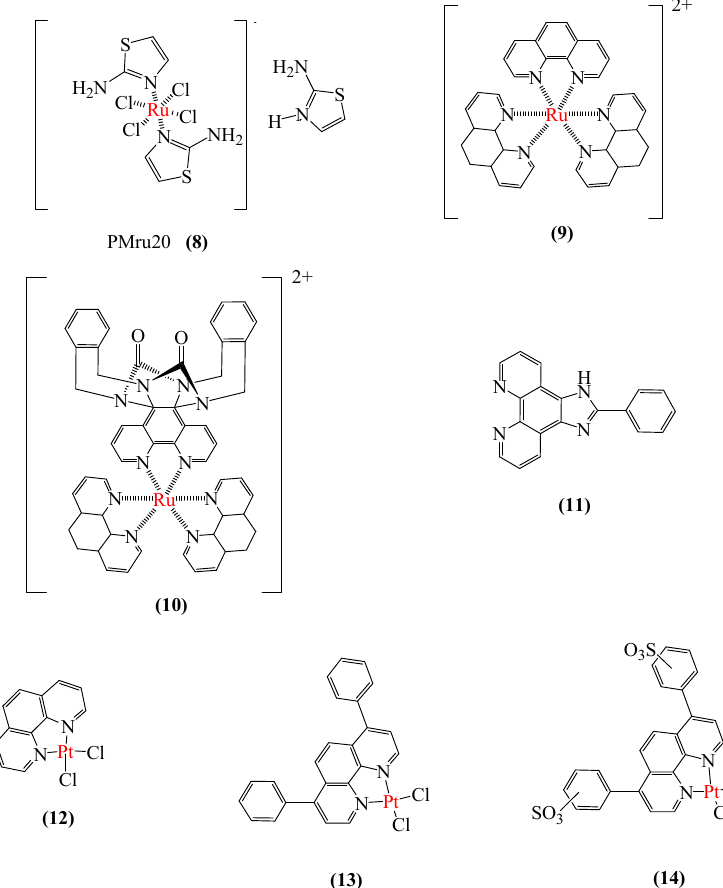
Figure 8. Chemical structures of A β -Aggregation Inhibitors, with metal in red color. Molecule 8 are the Ru complex PMRU20; 9 and 10 are Ru(II) polypyridyl complexes; 11 is a phenyl-imidazo-phen ligand, and 12 , 13 and 14 are platinum